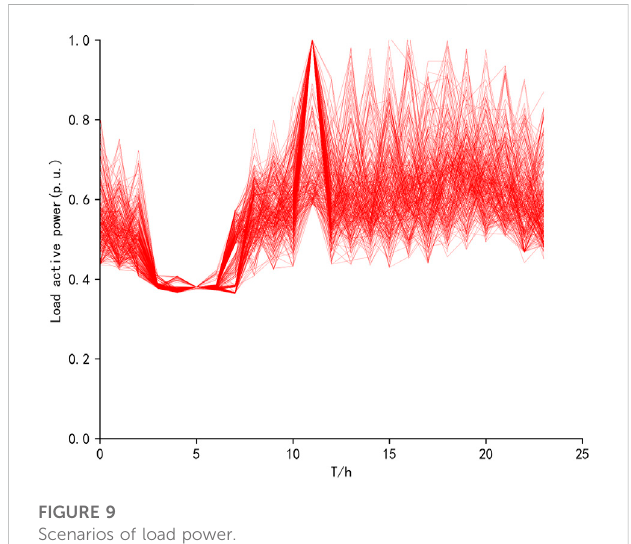
Scenarios of load power.